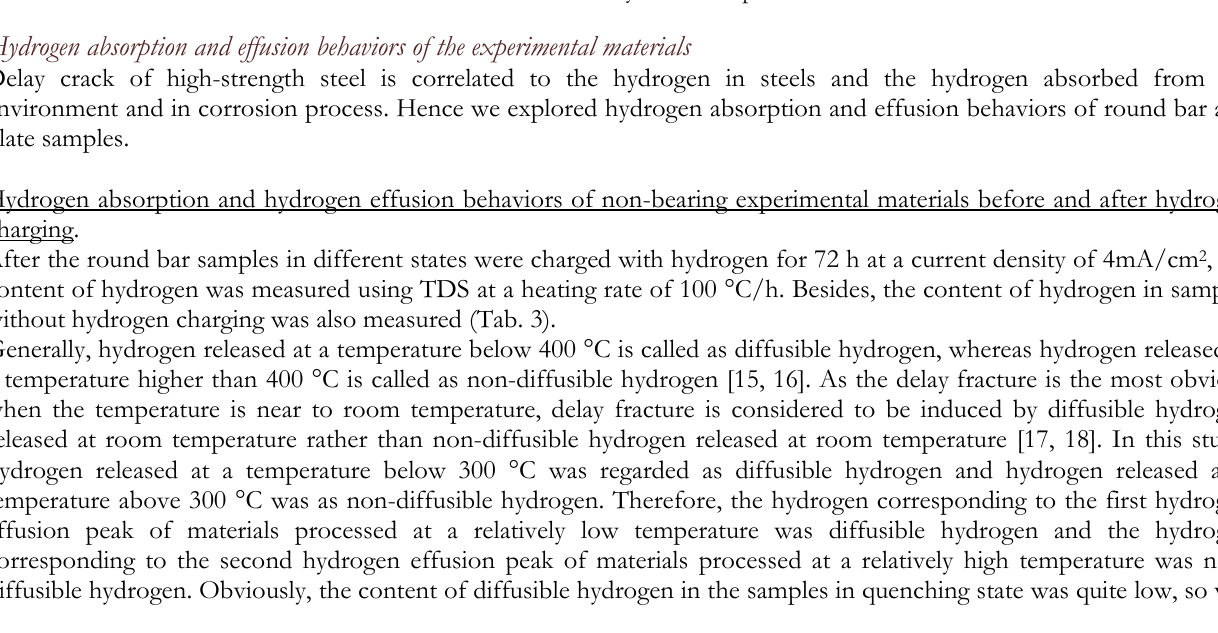
Table 2: Results of delay fracture